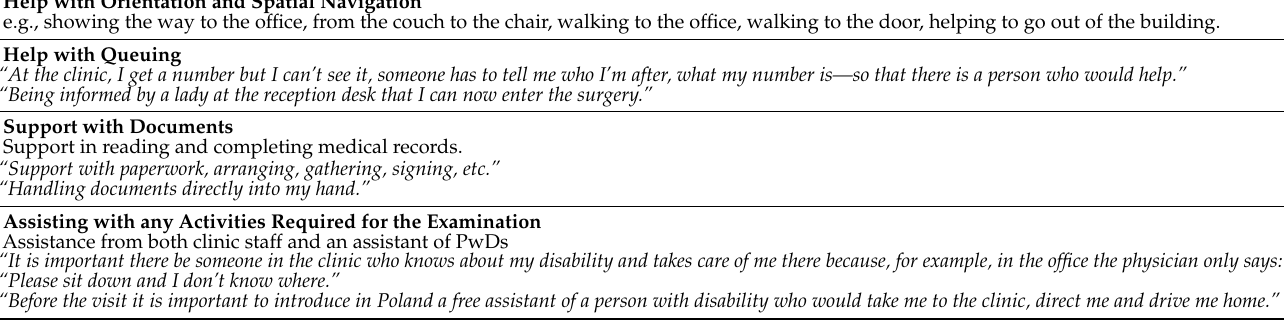
Table 5. Specific needs of patients with